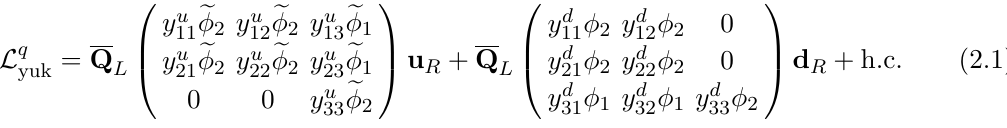
MeV-multi-GeV range, the scale of U(1) (3)